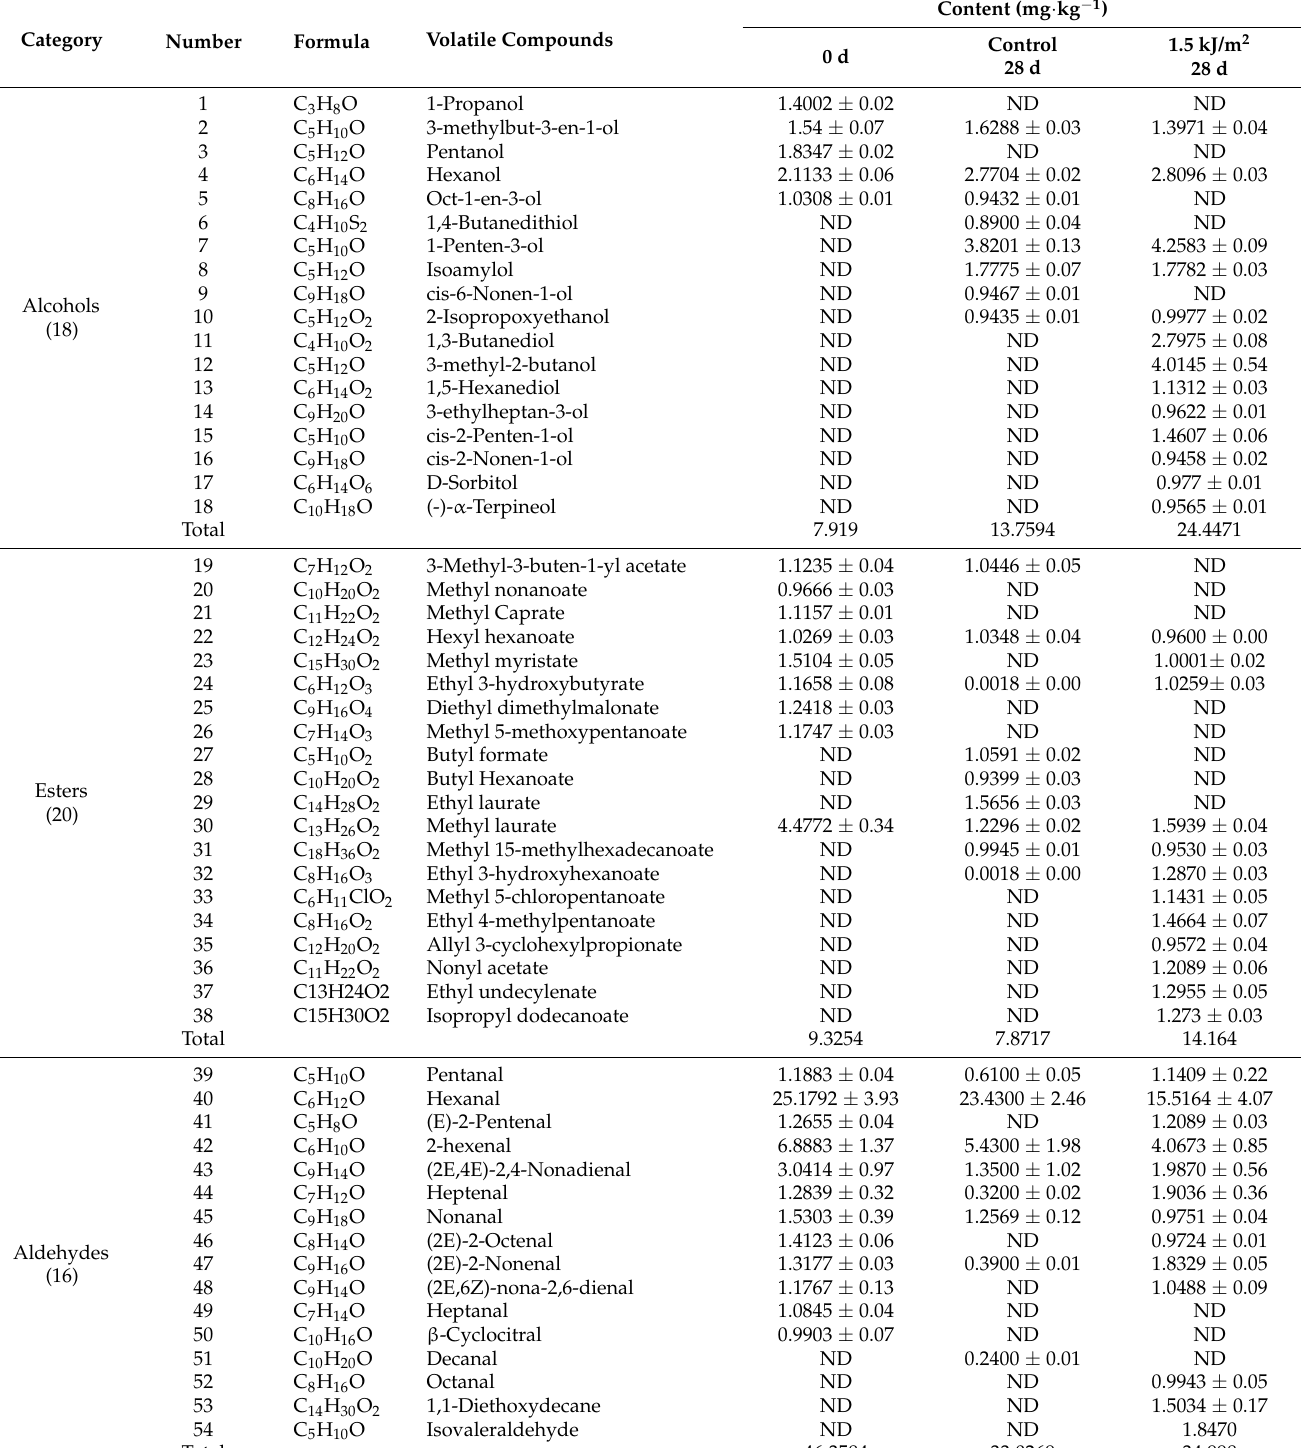
Table 1. Quantitative results of the level of aroma compounds in pepino fruit during storage for 0 d and 28 d.